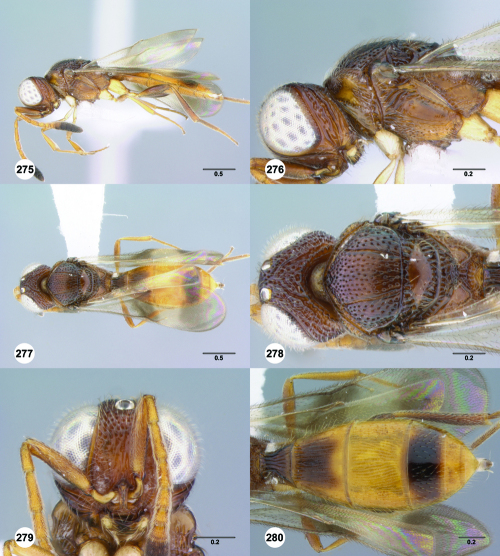
113Trichoteleia tigris sp. n., female holotype (CASENT 2043960). 275 Lateral habitus 276 Head and mesosoma, lateral view 277 Dorsal habitus 278 Head and mesosoma, dorsal view 279 Head, anterior view 280 Metasoma, dorsal view. Scale bars in millimeters.